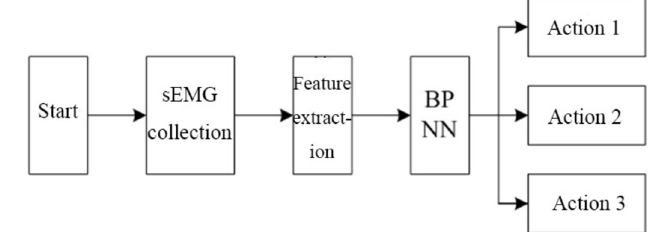
Fig. 6. Real-time control fl ow of mechanical simulated arm.